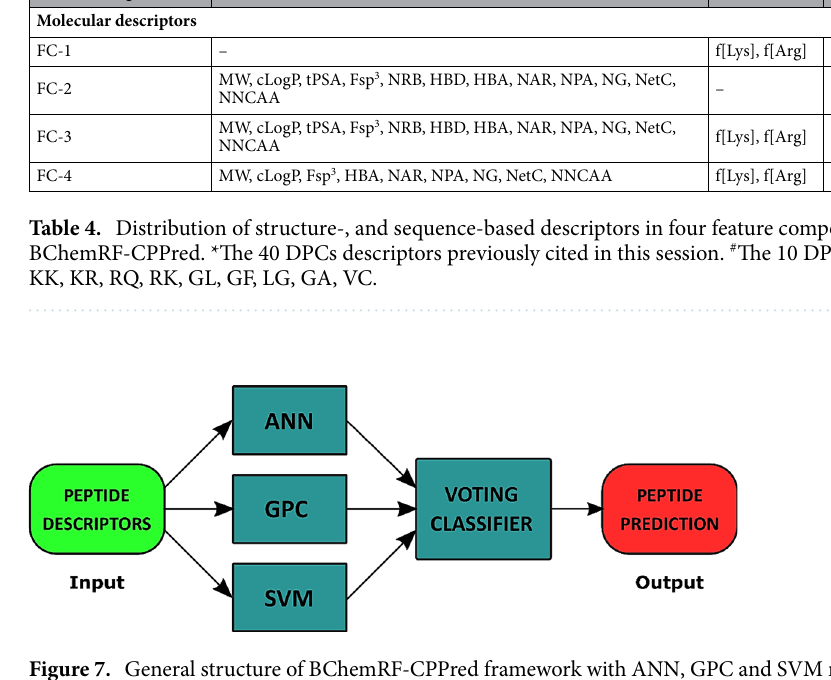
Figure 7. General structure of BChemRF-CPPred framework with ANN, GPC and SVM machine learning algorithms.